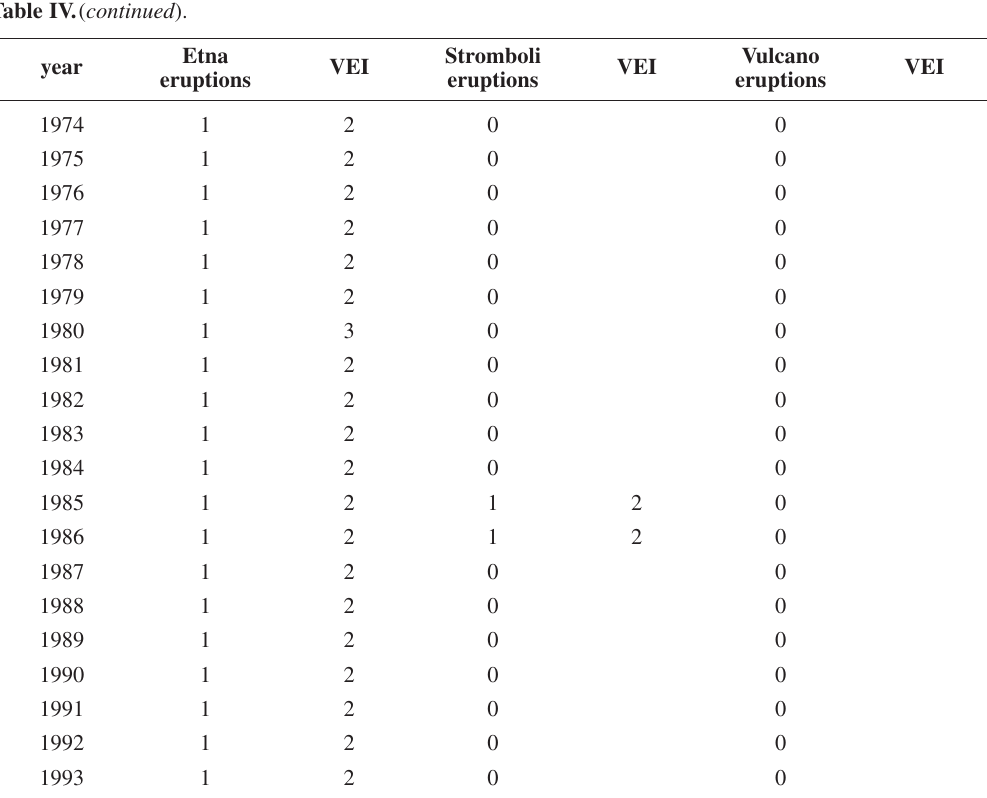
Table V. Monthly totals of seismic moment (T M 0 ) for the Etnean and Aeolian areas, from January 1983 to De- cember 2007 ( i.e. 300 months). Seismic moments are computed from earthquake magnitudes provided in the